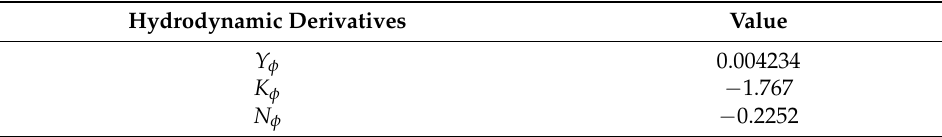
Figure 7. Calculation results of pure heel motion. Table 7. Hydrodynamic parameters related to pure heel